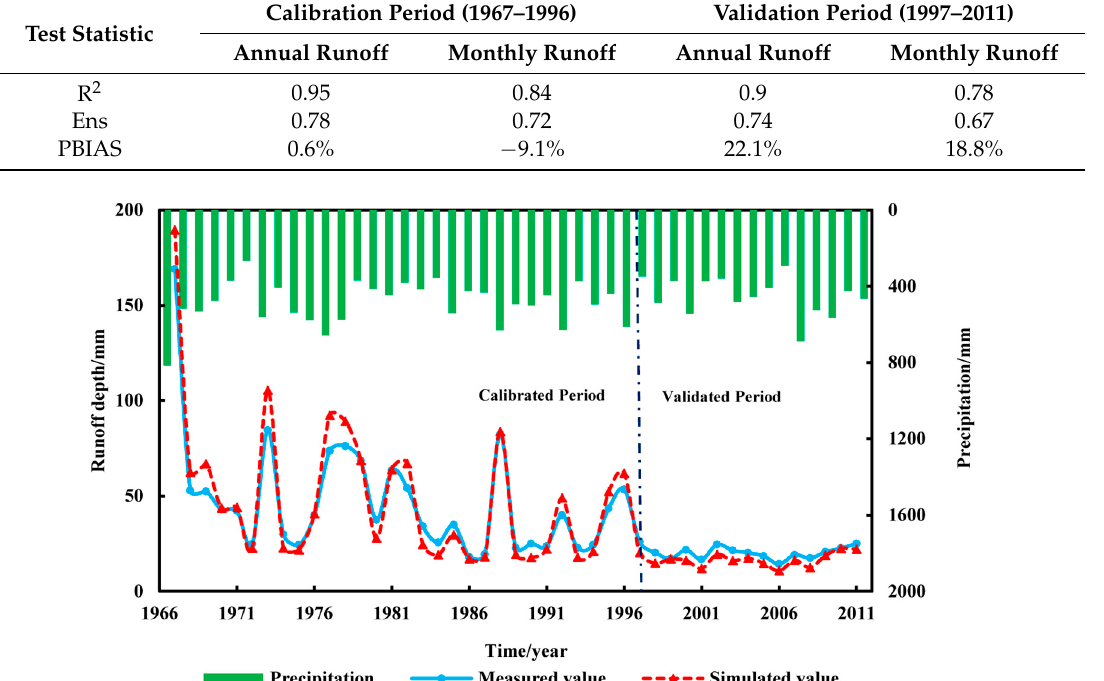
Figure 6. Observed and simulated annual streamflows at Shangjingyou Station.